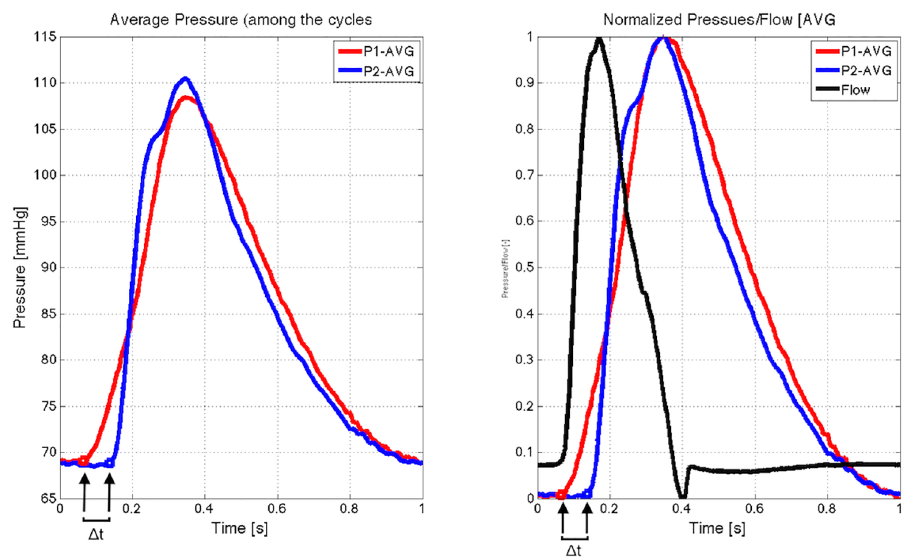
Fig 1. Generated pressurecurves (averageof five recorded cycles) in the ascending aorta and in the descending aorta at the level of the celiac trunk. The distance between both pressuresensors was divided by the difference in time between the base of the pressure curves to calculate aortic pulse wave velocity . Red: ascendingaorta, blue: descending